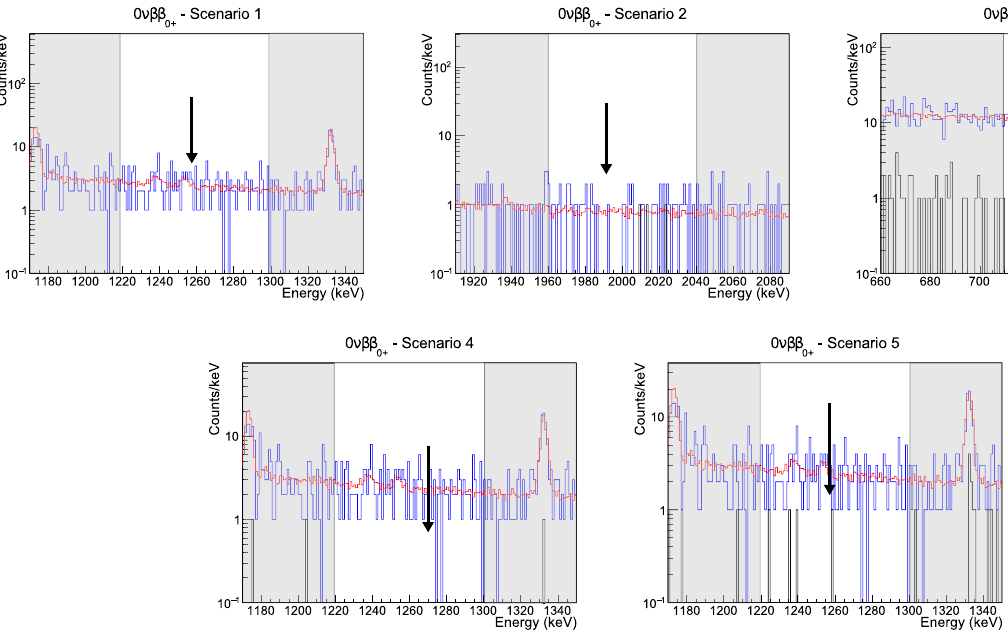
Fig. 3 CUORE-0 spectra for the five signatures selected for the 2 νββ decay. The blue histogram shows the data without any energy- 0 + 1 related cut; the reconstruction of the background model is shown in red;